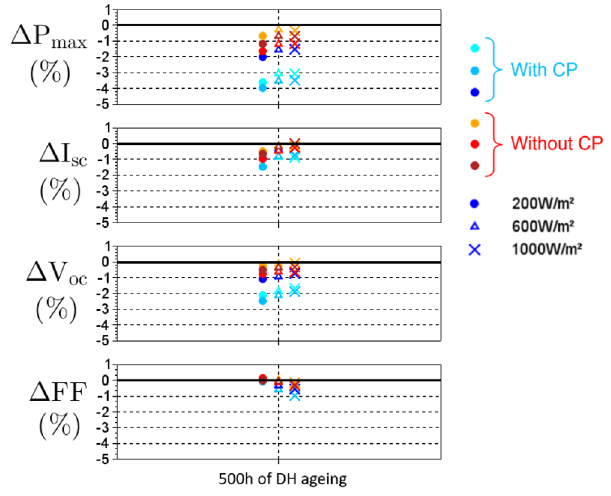
Fig. 11. PV modules power losses after 500h of DH.